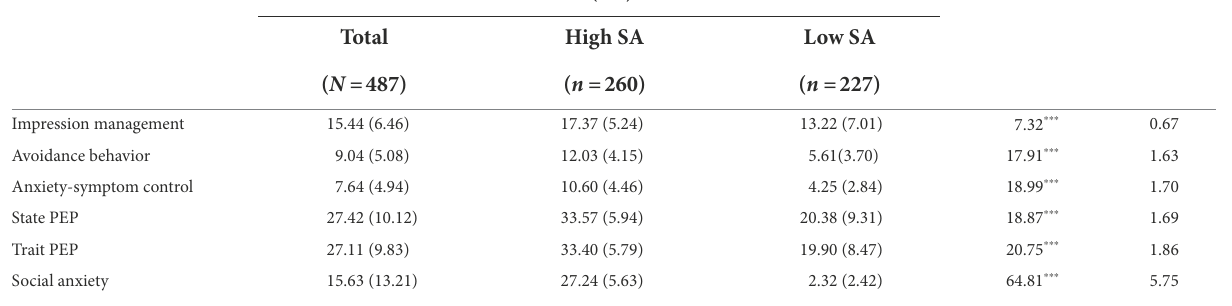
TABLE 2 Group differences in the major